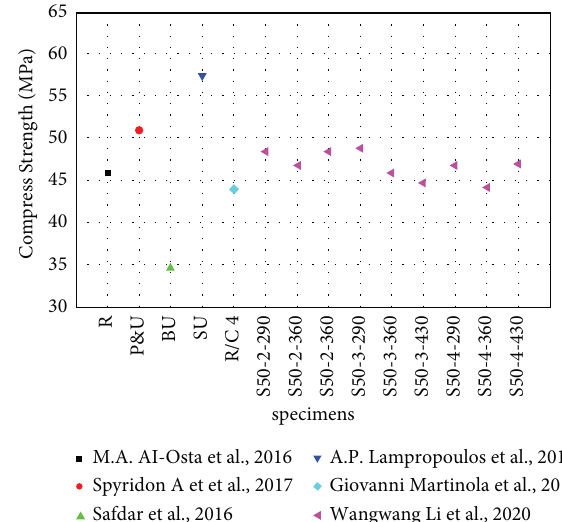
Figure 3: Te distribution of NC compressive stress.